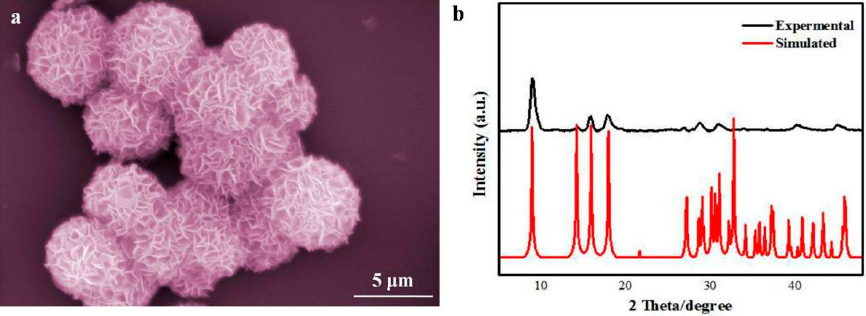
2+ ion solution into the ligands solution as well. In the SEM images, Figure 6a showed